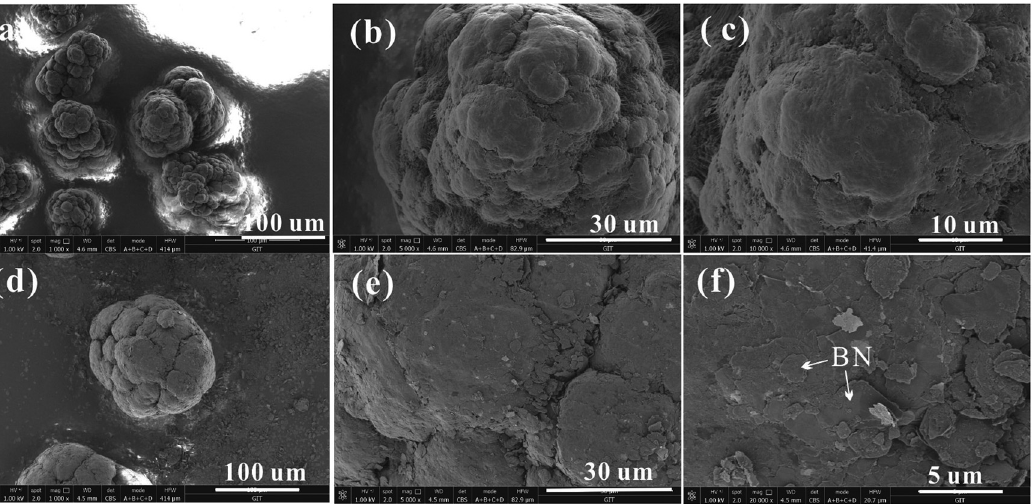
Figure 2: Particle morphological SEM images of UHMWPE granules ( a – c ) and BN - coated UHMWPE granules with 4.4 vol% of BN ( d – f )